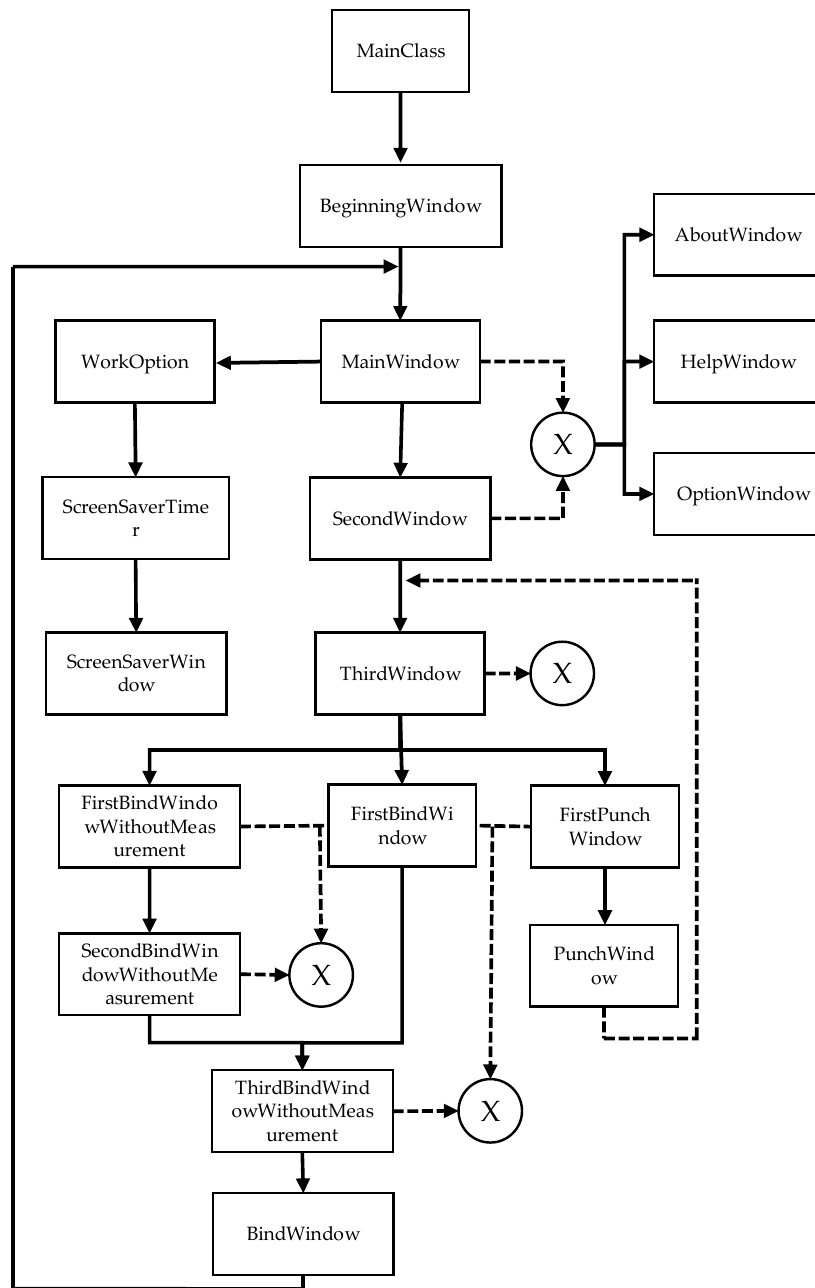
Figure 33. Association between program classes.